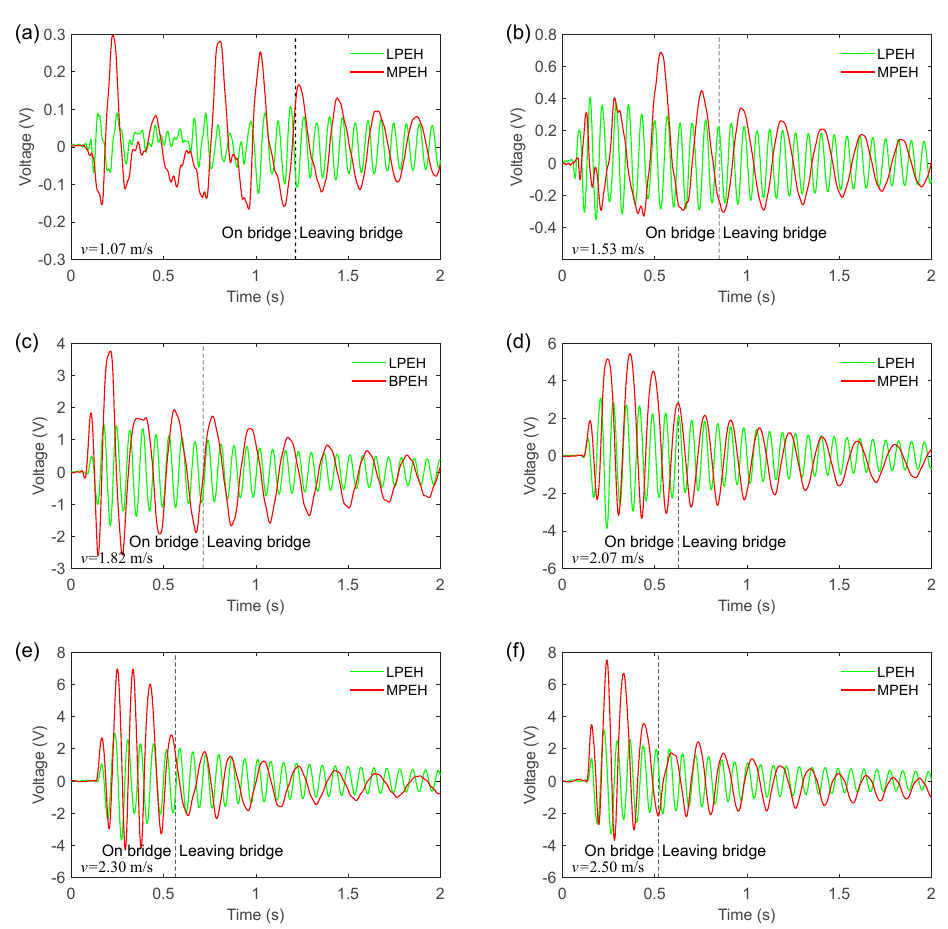
Figure 10. Voltage output of the LPEH and MPEH for the vehicle travelling on and leaving the bridge: ( a ) v = 1.07 m/s, ( b ) v = 1.53 m/s, ( c ) v = 1.82 m/s, ( d ) v = 2.07 m/s, ( e ) v = 2.30 m/s and ( f ) v = 2.50 m/s.